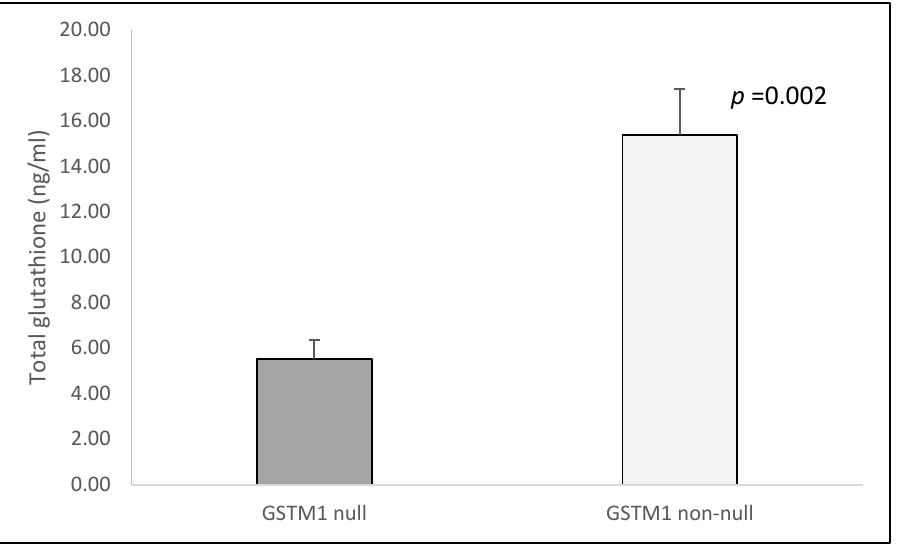
Figure 4. Total glutathione levels in controls according to GSTM1 genotypes. The total glutathione is presented as mean ± standard error of mean (SEM).